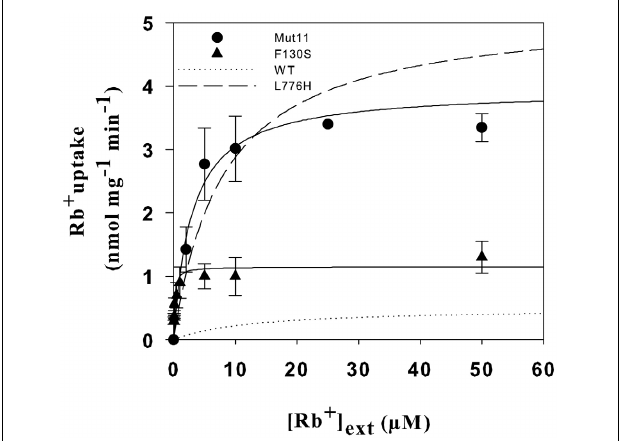
FIGURE 6 | Initial rates of Rb + uptake as a function of external Rb + in 9.3 cells expressing the AtHAK5 mutants. Cells of the 9.3 strain expressing the Mut11 and F130S mutants were grown overnight on minimal AP media supplemented with 30mM K + . After 6h of incubation in K + -free AP media cells were transferred to uptake buffer supplemented with different Rb + concentrations. The initial rates of Rb + uptake for each external Rb + concentration were determined and plotted for Mut11 (closed circles) and F130S (closed triangles). Values were fitted to Michaelis-Menten equations. The predicted curves for WT (dotted line) and the L776H mutation (dashed line) are also shown (Rubio et al., 2000).